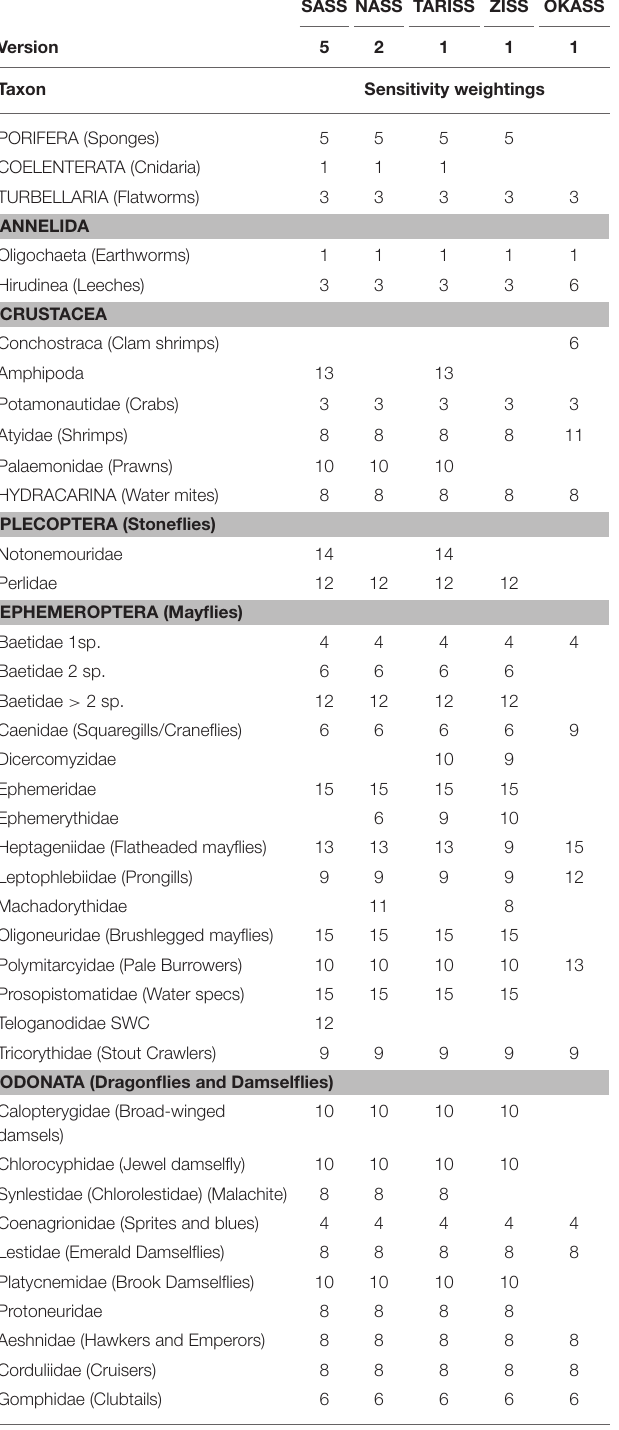
TABLE 2 | Taxa and sensitivity weightings for Rapid Bioassessment Protocols currently used in Africa, including the South African Scoring System (SASS, Dickens and Graham, 2002), Namibian Scoring System (NASS, Palmer and Taylor, 2004), Tanzania River Scoring System (TARISS, Kaaya et al., 2015) and Zambian Invertebrate Scoring System (ZISS, Dallas et al., 2018), and Okavango Assessment System (OKASS, Dallas,